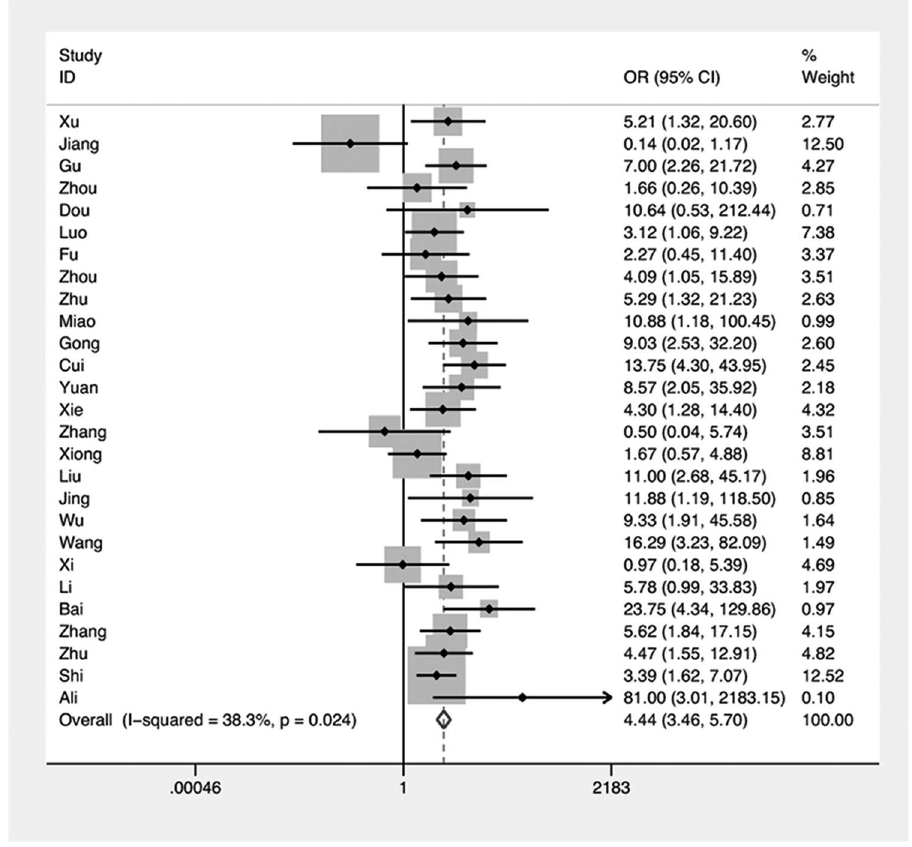
Fig 3. Forest plot:odds ratio (OR) for COX-2 expression and lymph node metastasisin NPC.